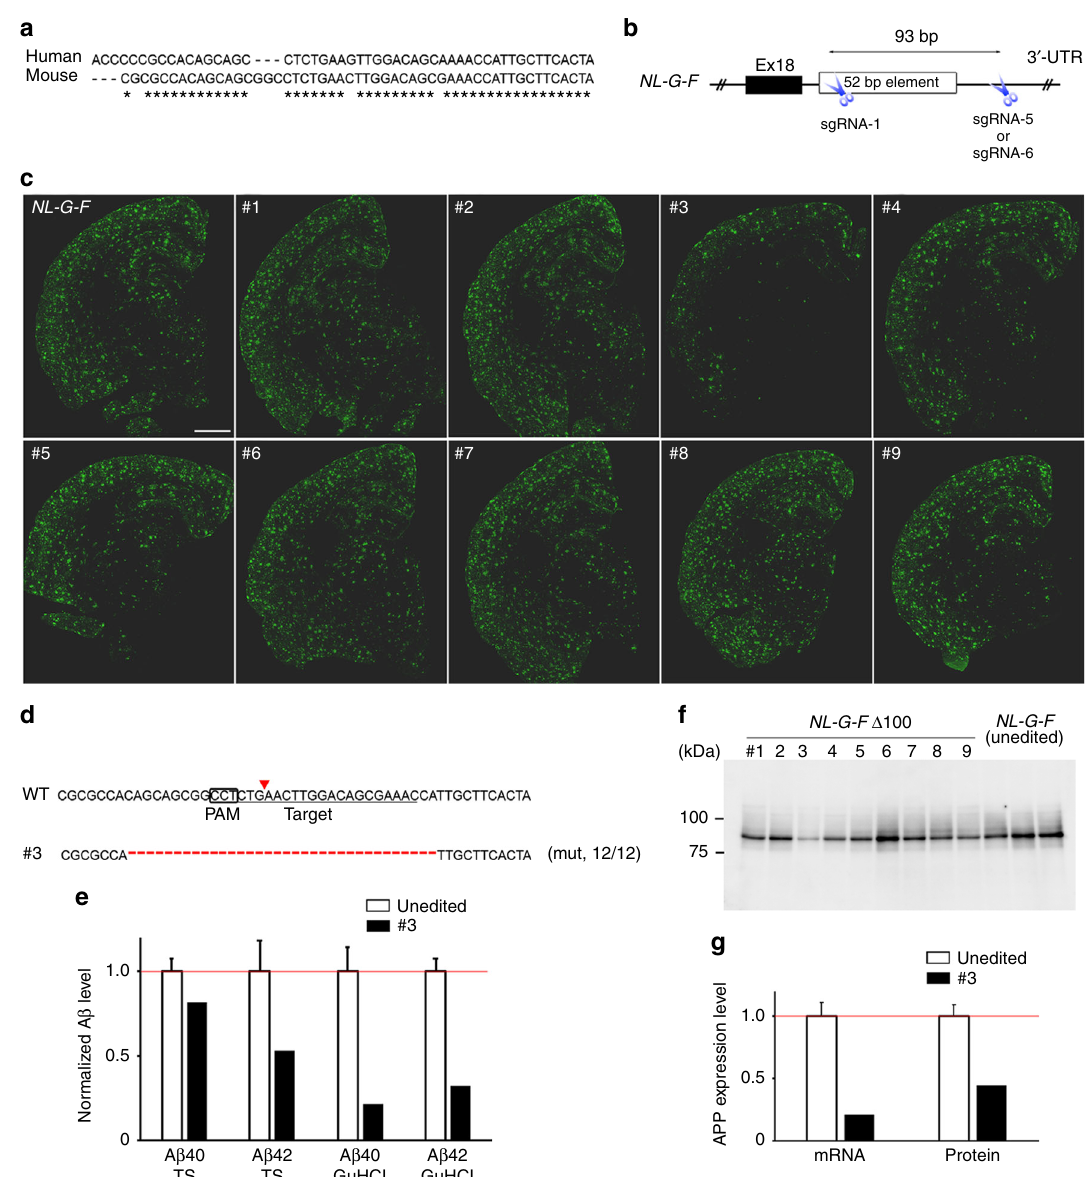
Fig. 3 In vivo exploration of the regulatory elements on App 3 ′ -UTR. a Sequence conservation of 52-bp regulatory element between the mouse and human. b Strategy for in vivo disruption of the 52-bp element by CRISPR/Cas9. Positions of targeting sgRNAs are shown by scissors. c A β pathology in 6-month- old NL-G-F Δ 100, as well as unedited control NL-G-F brains. Scale bar: 1 mm. d Sequence analysis of founder #3 with bi-allelic 34-bp deletion. The fractions on the right indicate the mutant reads number out of total reads number. e Reduced A β levels in a 6-month-old NL-G-F Δ 100 mouse brain (#3). Three unedited NL-G-F samples were used for normalization. The unedited control data represent mean ± SD. f A representative APP western blot image for 6- month-old NL-G-F Δ 100 mouse brains. g Reduced APP expression at transcriptional and translational levels in a NL-G-F Δ 100 mouse brain (#3). Three unedited NL-G-F samples were used for normalization. The unedited control data represent mean ±